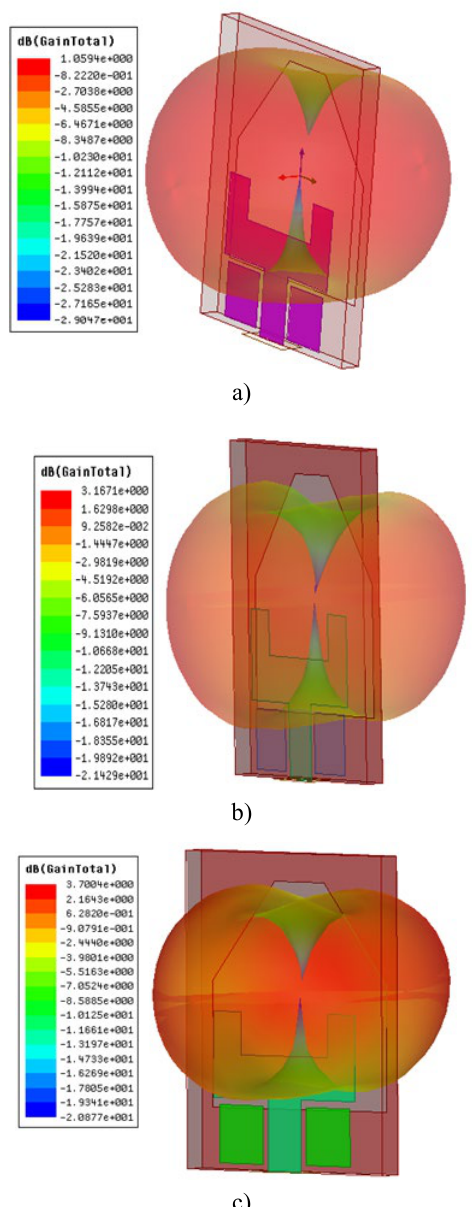
Fig. 6. Simulated 3D gain of the proposed antenna at a) 5.7 GHz, b) 8.2 GHz, c) 11.2